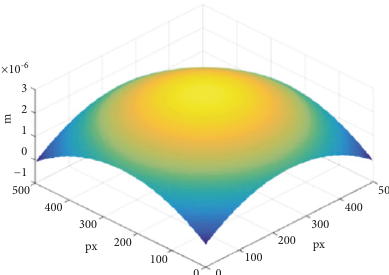
Figure 4: 3D view of dual-wavelength phase